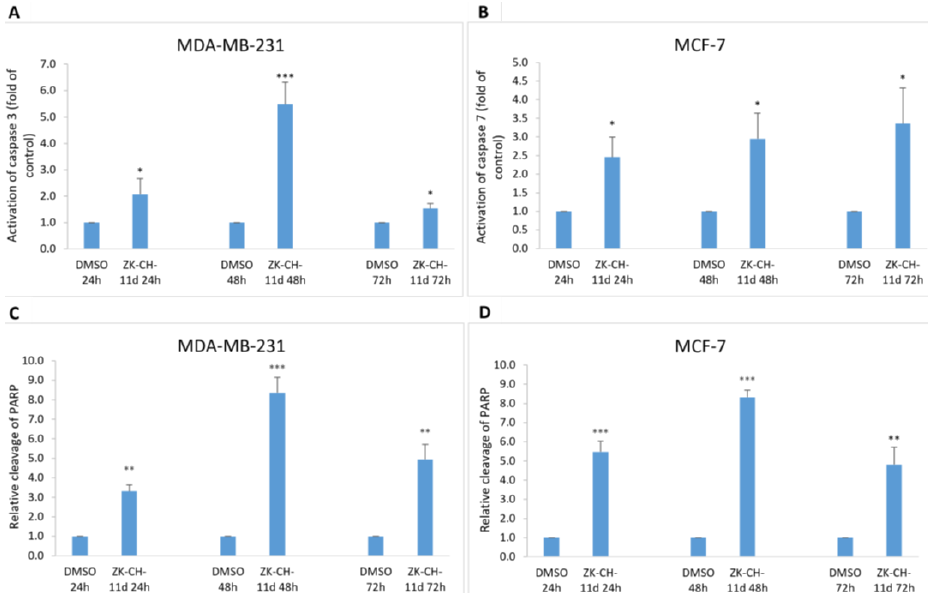
Figure 11. Flow cytometric analysis of caspase activation and induction of PARP cleavage. Relative activation of caspase 3 in MDA-MB-231 cells ( A ) and caspase 7 in MCF-7 ( B ) cells after ZK-CH-11d treatment at 24, 48, and 72 h and relative PARP cleavage in MDA-MB-231 ( C ) and MCF-7 cells ( D ). The values shown are the mean of three independent experiments compared to the control (DMSO). Statistical significance: * p < 0.05, ** p < 0.01, *** p <